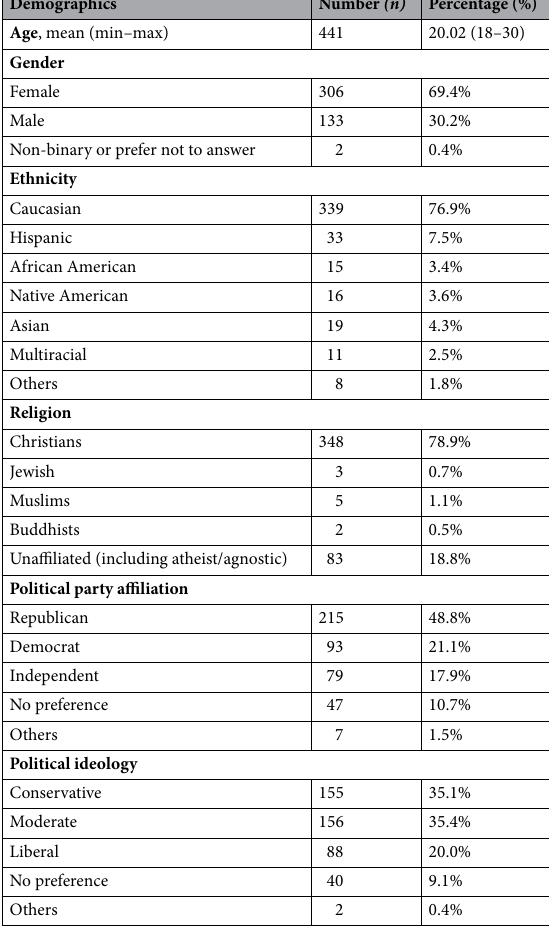
Table 3. Demographic characteristics of respondents in Study 2 ( n =